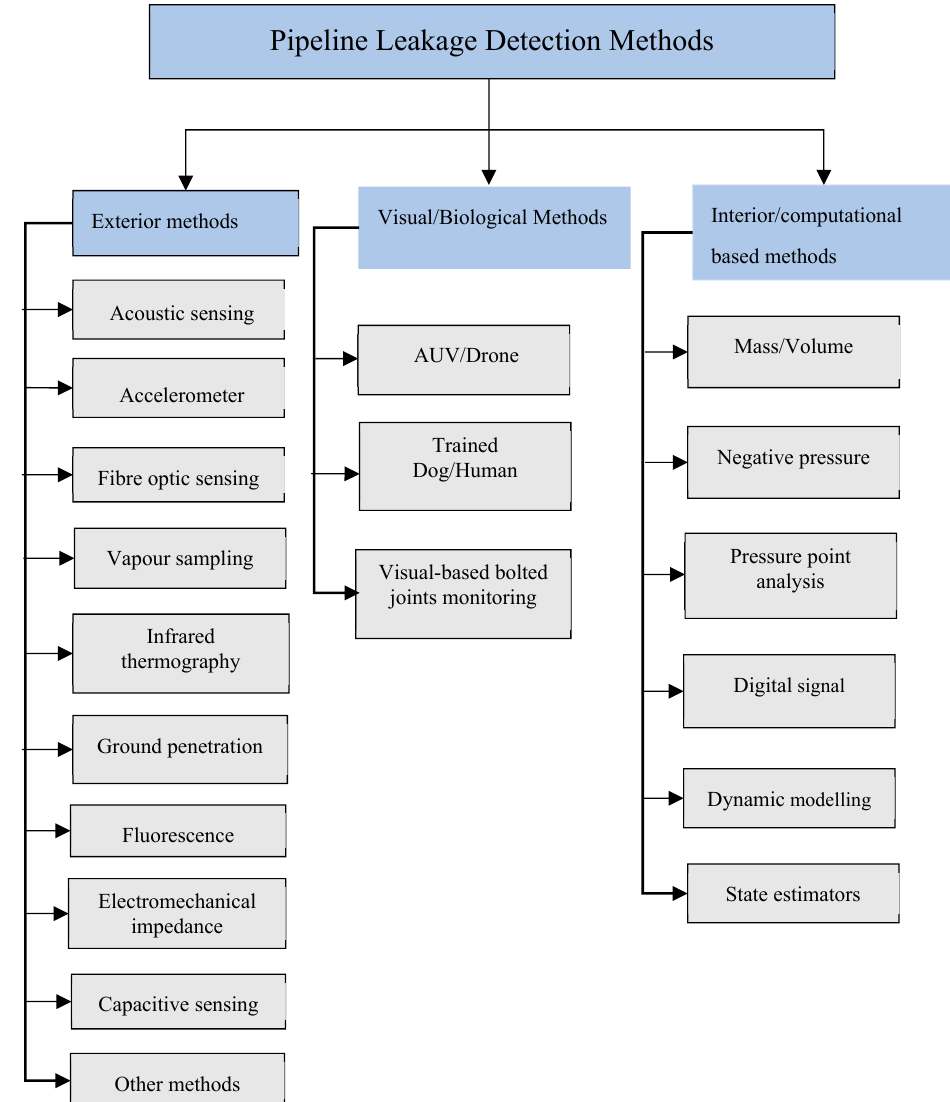
Figure 2. Flow chart of different pipeline leakage detection approaches.